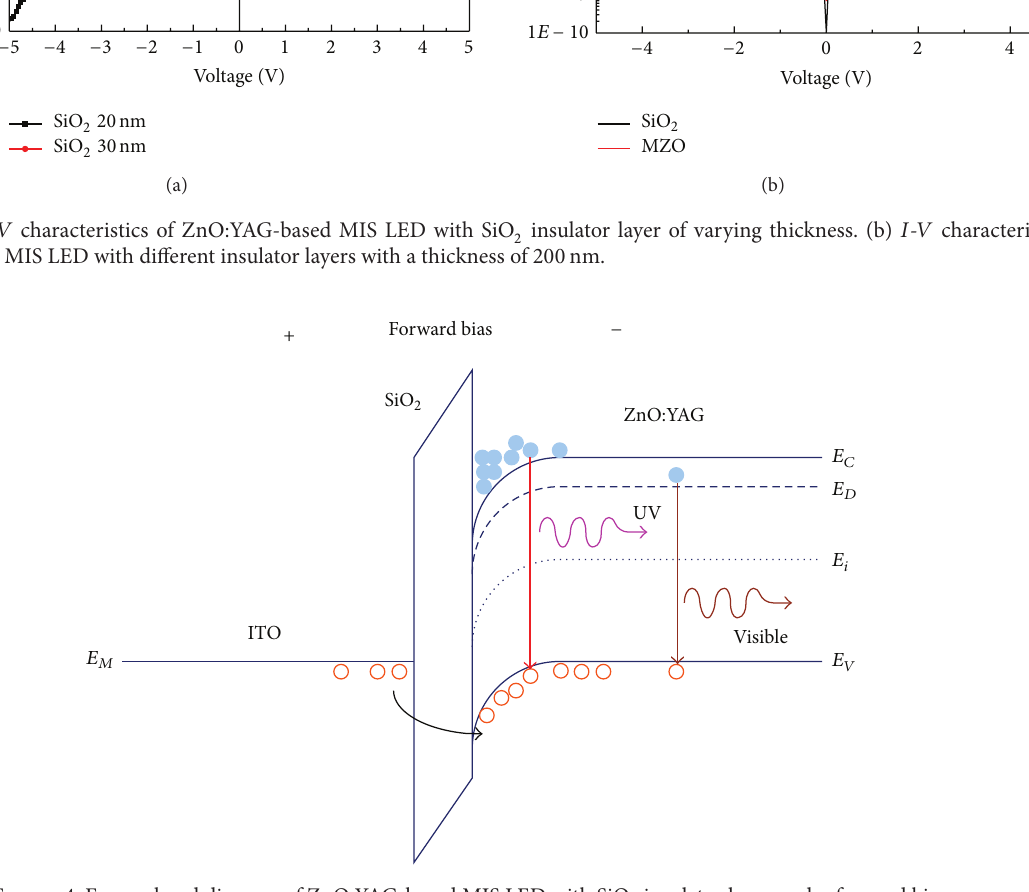
Figure 4: Energy band diagram of ZnO:YAG-based MIS LED with SiO 2 insulator layer under forward